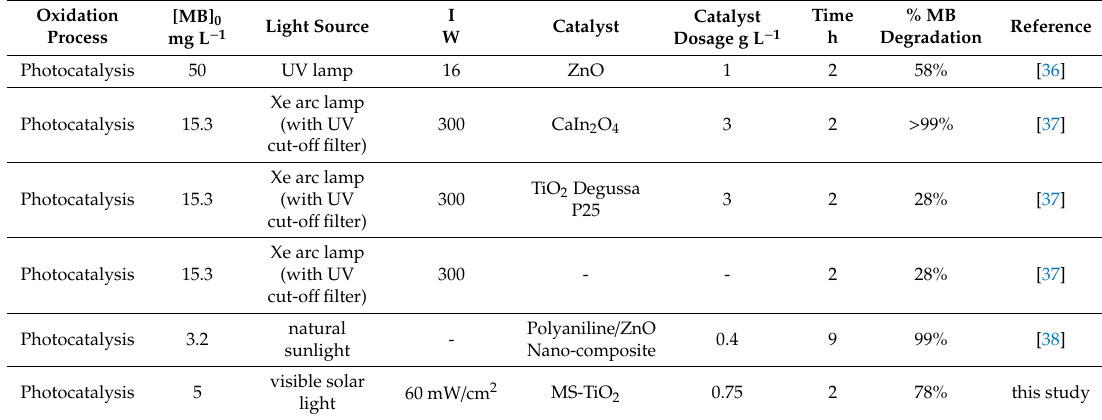
Table 5. Degradation of MB under di ff erent photocatalytic